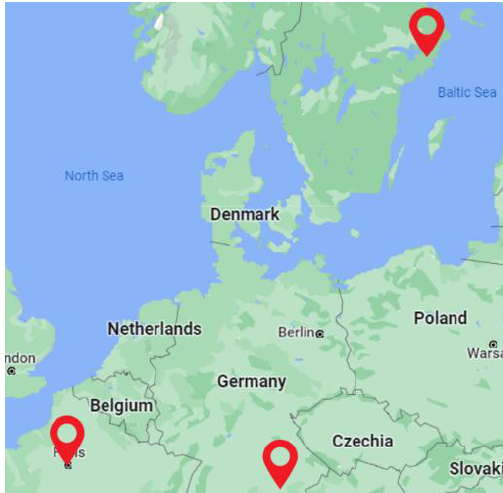
Figure 8. Location of three represented European cities.